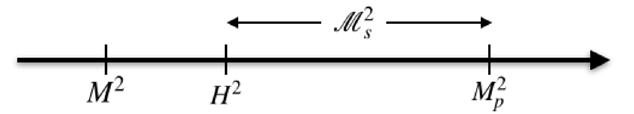
Figure 1 . Hierarchy of mass scales in non-local R 2 -like